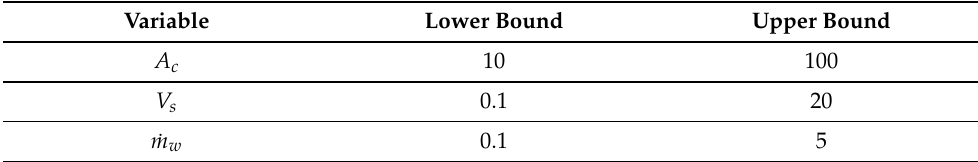
Table 4. The optimization